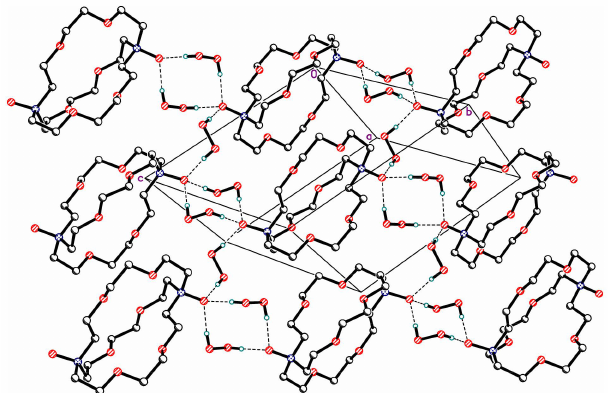
Figure 4. Hydrogen bonded layer in II . Hydrogen bonds are shown by dashed lines.